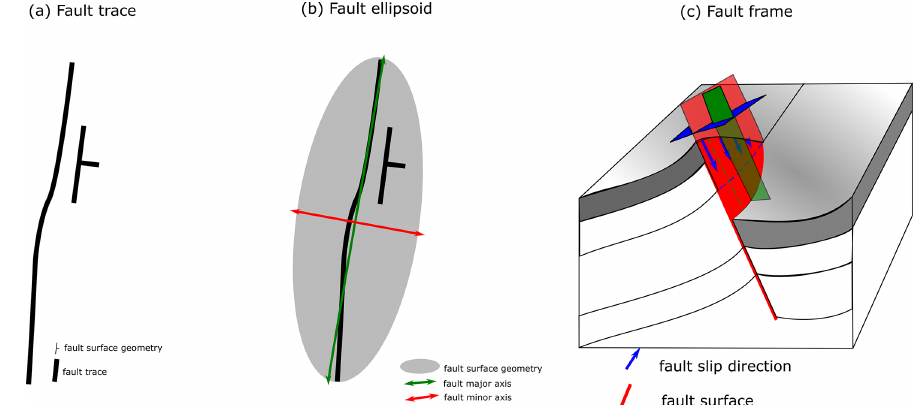
Figure 4. Schematic diagram showing the construction of a fault frame from a fault trace. (a) Fault trace and structural data for fault plane geometry. (b) Fault ellipsoid defined by the major axis and minor axis. (c) Fault frame showing fault surface (red), fault slip (blue) and fault extent